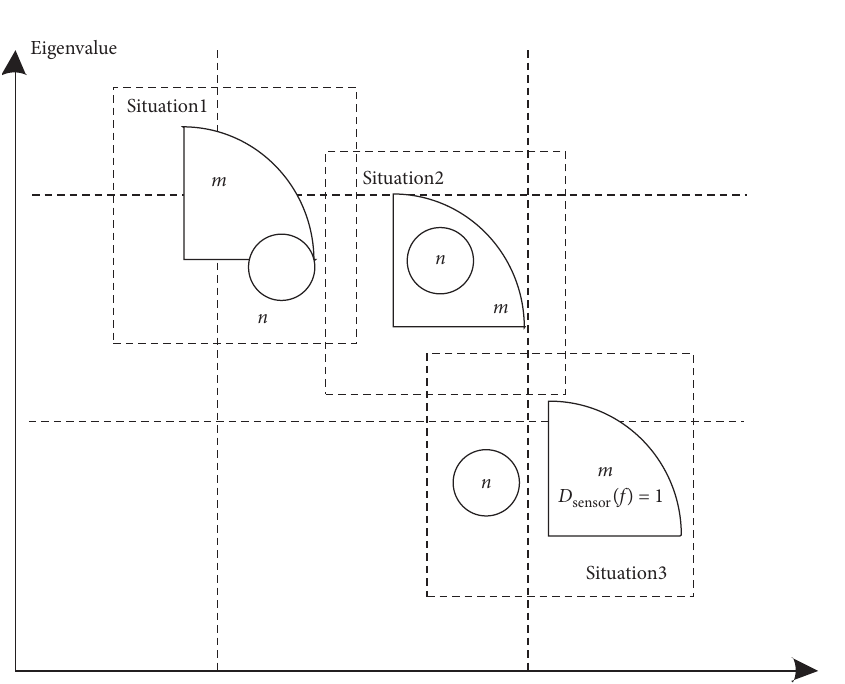
Figure 3: Cloud push cycle.